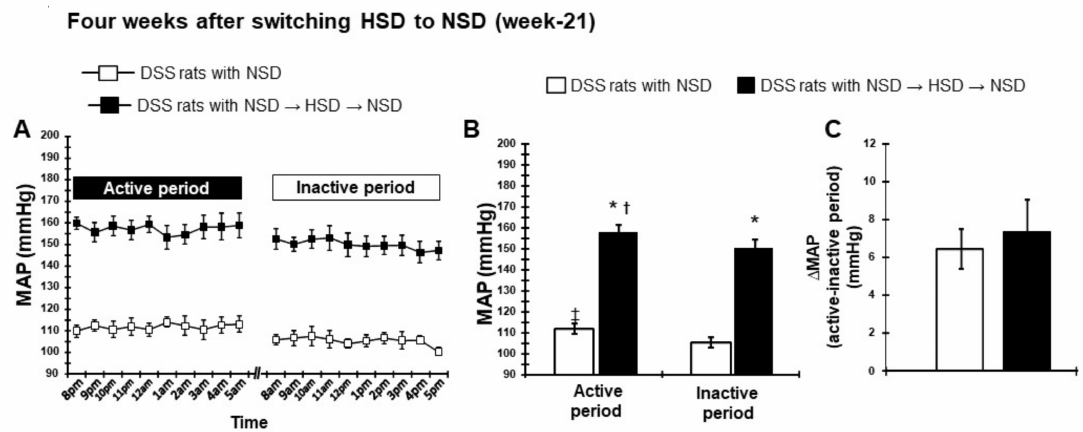
Figure 4. Circadian rhythm of MAP after switching to NSD (week 18–21). ( A ) Hourly MAP, ( B ) averaged 10-h MAP in active and inactive periods, and ( C ) the di ff erence of 10-h MAP between active and inactive periods at 4 weeks after switching HSD to NSD. * p < 0.05 vs. DSS rats with NSD; † p < 0.05, DSS rats with NSD → HSD → NSD (inactive period) vs. DSS rats with NSD → HSD → NSD (active period); ‡ p < 0.05, DSS rats with NSD (inactive period) vs. DSS rats with NSD (active